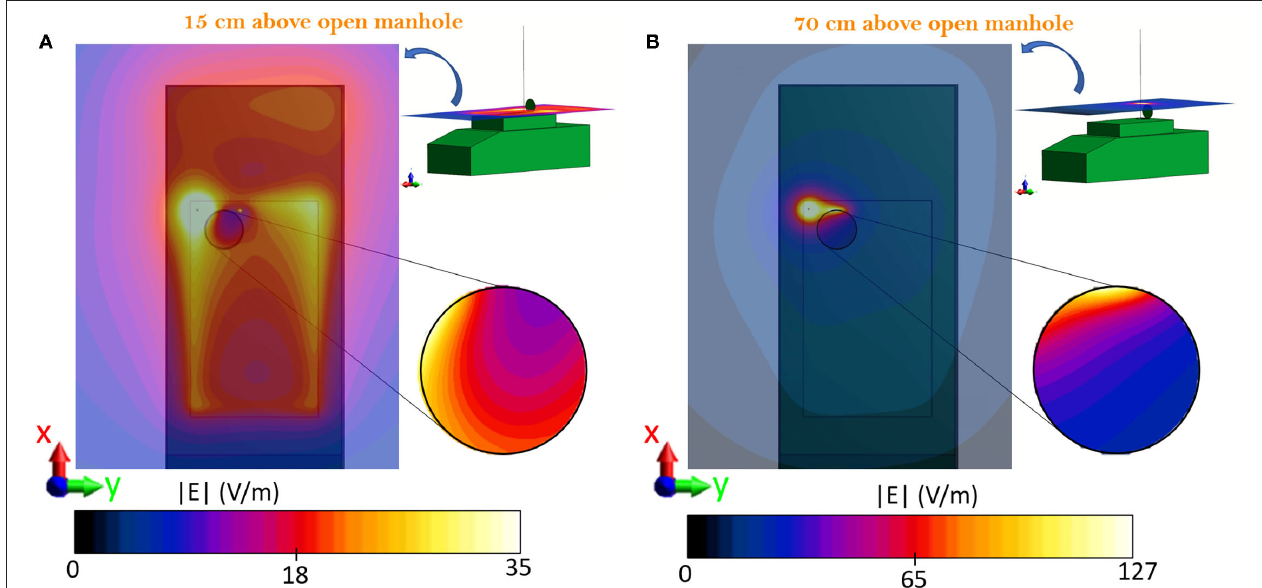
FIGURE 3 | Top view of the vehicle and distribution map of the E-field radiated by the antenna model fed with 25W at 16 MHz. (A) Distribution at 15cm above the manhole, circular inset: detail of the manhole area. (B) Distribution at 70cm above the manhole, circular inset: detail of the manhole area. The vehicle and manhole boundaries are shown by the light black lines.